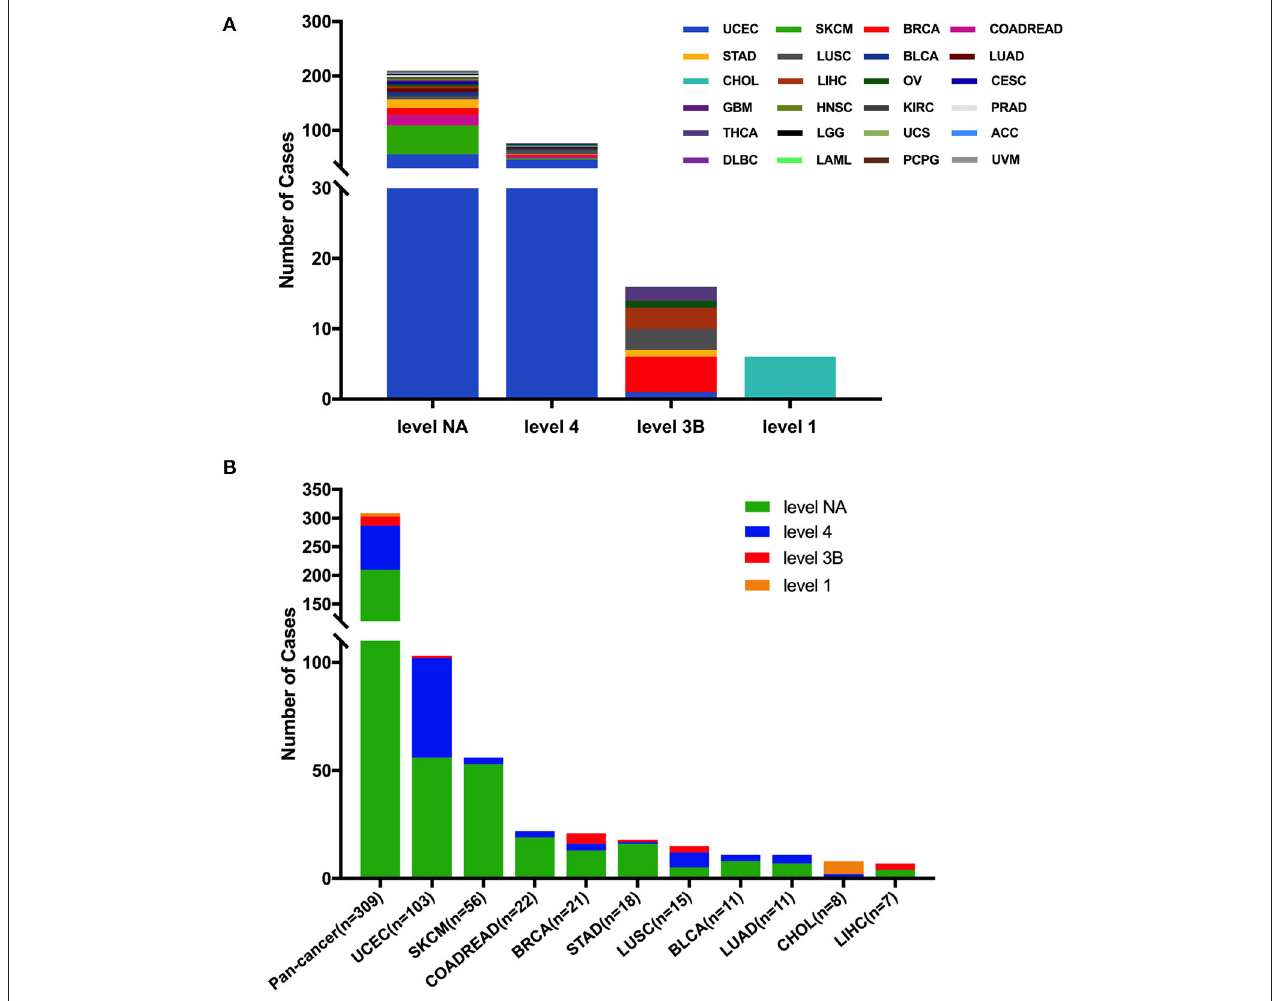
FIGURE 6 | FGFR2 mutation classification based on targeted therapy implications. (A) FGFR2 mutation classification based on the clinical targeted treatment implications as annotated in OncoKB across 32 TCGA cancer types together. (B) Targeted treatment implications distribution of FGFR2 mutations for all TCGA cancers together and for top 9 cancer